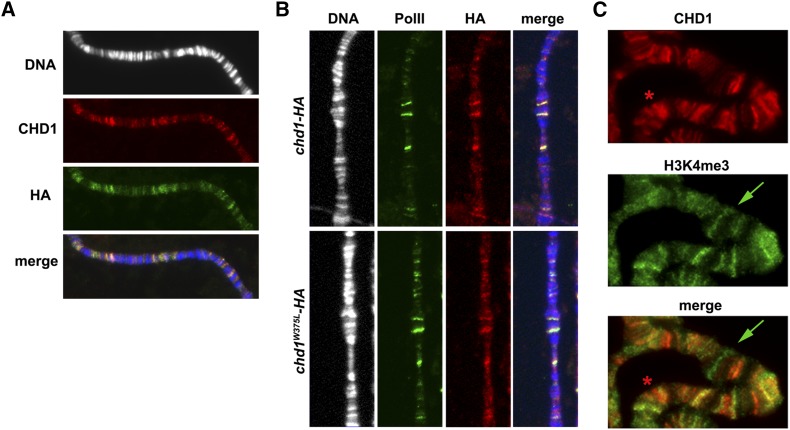
The H3K4me3 mark is not sufficient to recruit CHD1. (A) HA-tagged CHD1 localized to all sites bound by endogenous CHD1. Chromosomes were stained with DAPI (white in top panel, blue in merge) and coimmunostained with anti-CHD1 (red) and anti-HA (green) as described (Lavrov et al. 2004). (B) CHD1 localization was not altered in P[chd1W375LHA, w+]44-1 larvae compared to P[chd1+HA, w+]42-2 larvae. Chromosomes were labeled with DAPI (white in left panel, blue in merge), anti-Pol IIoser2 (green), and anti-HA (red) as described (Lavrov et al. 2004), region 46–53 of chromosome 2R shown for comparison of binding patterns. (C) CHD1 does not completely colocalize with the H3K4me3 histone mark in P[chd1+HA, w+]42-2; chd15 b c sp larvae. While CHD1 (anti-HA, red) and H3K4me3 (green) patterns were similar (yellow in merge), several H3K4me3 sites lacked CHD1 (green arrow), and CHD1 sites occurred without H3K4me3 (red asterisk). Immunostaining was performed as described (Corona et al. 2007).